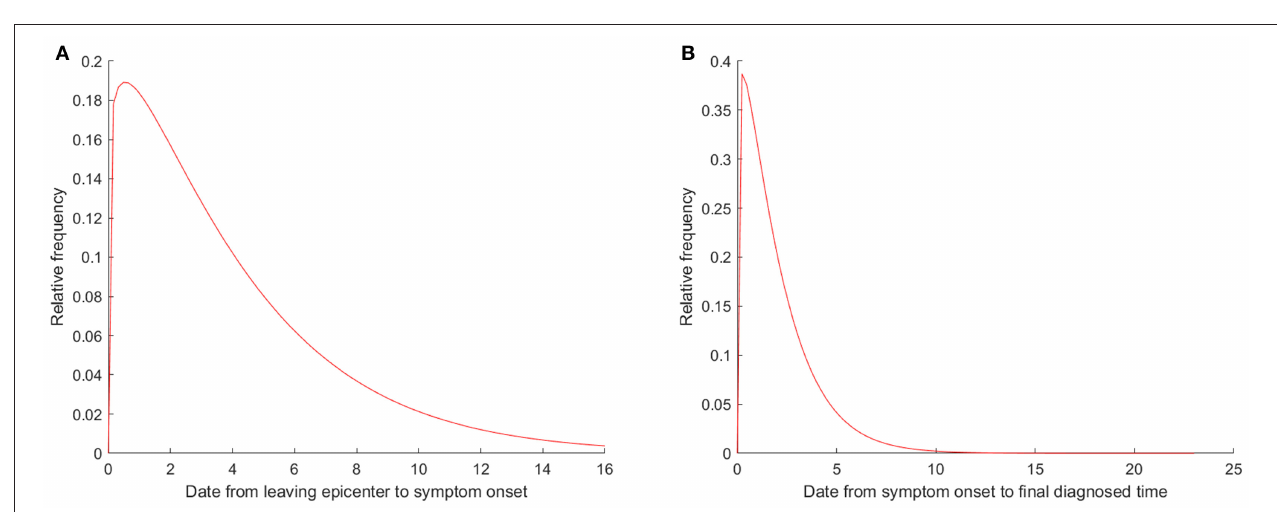
FIGURE 5 | Estimation of incubation period and diagnostic time by fitting Weibull distribution. (A) Incubation period estimated on the date of leaving epicenter; (B) Diagnostic time were estimated on the date of symptom